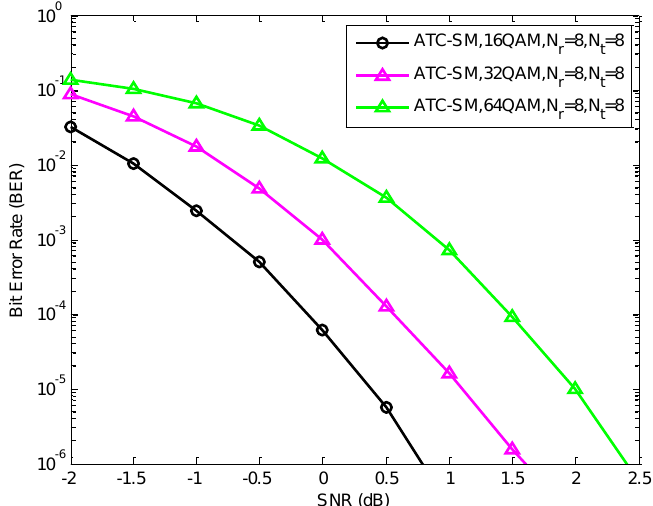
Figure 12. BER performance comparison of the ATC-SM scheme based on the CMI with di ff erent modulation schemes over the slow Rayleigh fading channel, K = 1024 and N r = N t = 8 .